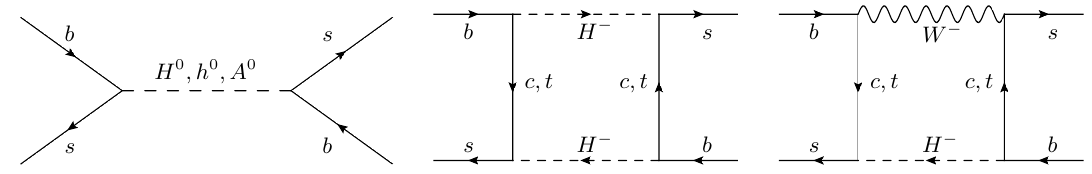
Figure 7 . Feynman diagrams contributing to B s (cid:0) (cid:22) B s mixing. Note that the tree-level contribution is absent for " d = " d = 23 32